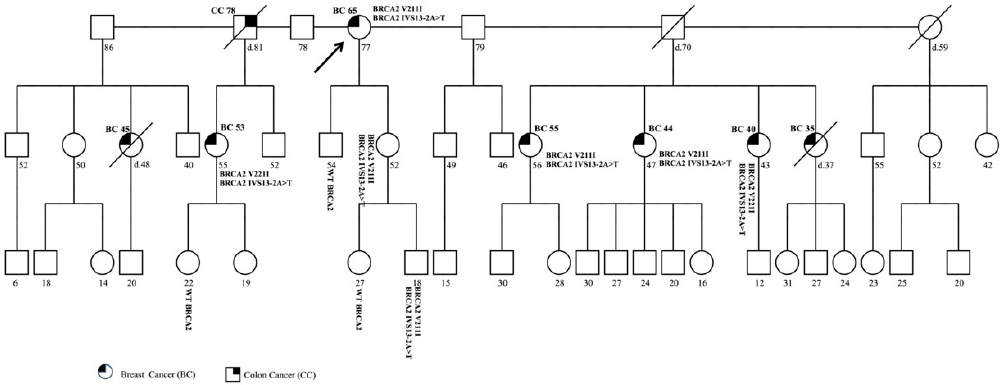
Figure 4. Pedigree of family 4 carrying the DM in BRCA2 c.631G > A (p.Val211Ile) and c.7008-2A > T (IVS13-2A > T). The ages at diagnosis are indicated in brackets.